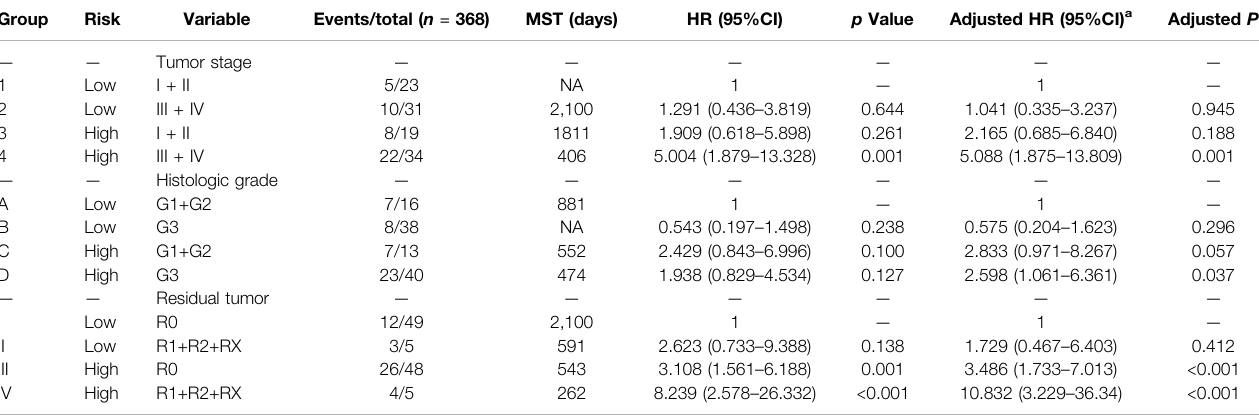
TABLE 3 | Clinical factors combined with risk factors for analysis of the overall survival of patients with gastric